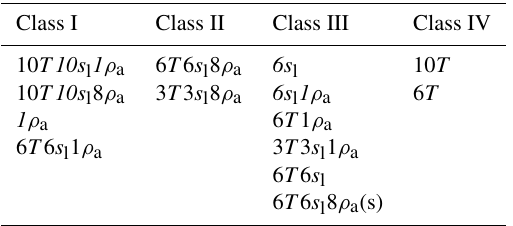
Table 3. K -means analysis of the accuracy for each of the 13